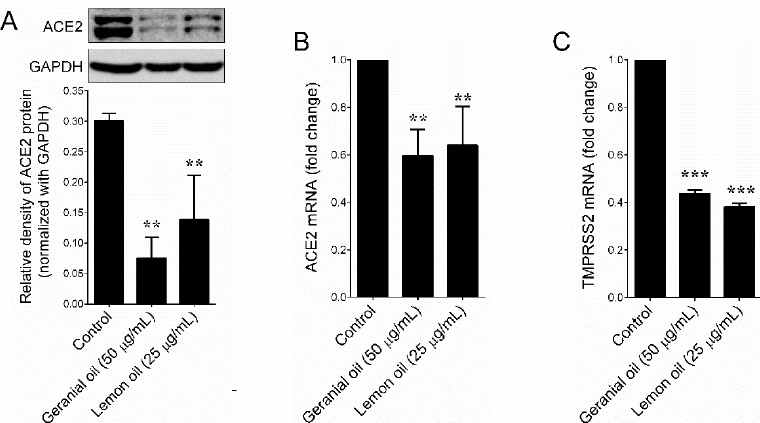
Figure 2. Geranium and lemon essential oils downregulated ACE2 expression in HT-29 cells. ( A ) Protein expression levels of ACE2 were determined by immunoblotting. Glyceraldehyde 3-phosphate dehydrogenase (GAPDH) was used as an internal loading control. Relative density of one representative experiment is shown, where ACE2 signal was normalized to GAPDH signal. ( B , C ) Relative expression of ACE2 and TMPRSS2 mRNAs in HT-29 cells. Total RNA was extracted from cells treated with indicated concentration of geranium and lemon essential oils for 48 h. The transcription levels of ACE2 and TMPRSS2 were quantified by qPCR and a representative experiment is shown. The ∆ ct values of ACE2 and TMPRSS2 mRNAs were normalized to GAPDH mRNA. Values represent the mean ± SD of three independent experiments. p -values of less than 0.01 **, and 0.001 *** were considered statistically significant for the sample treatment group vs. the control group.